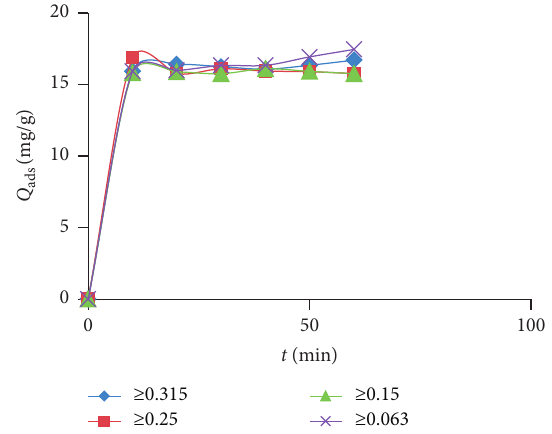
Figure 8: Influence of contact time on the adsorption of phenol on different granulometries of the sale clay.